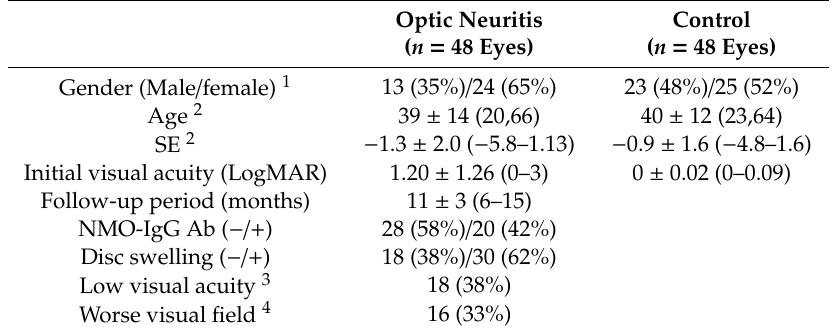
Table 1. Demographics and clinical characteristics of patients with optic neuritis and healthy